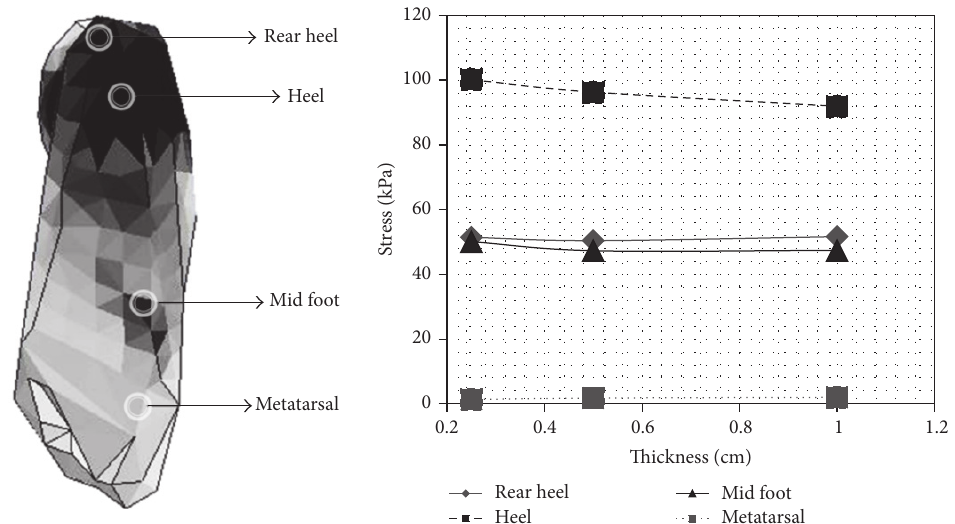
Figure 4: Variation of stress value in each node by changing the thickness for flat insoles. The stress is concentrated in two main regions: rear heel and heel. Moreover, increasing the thickness of insole does not necessarily lead to less maximum stress.